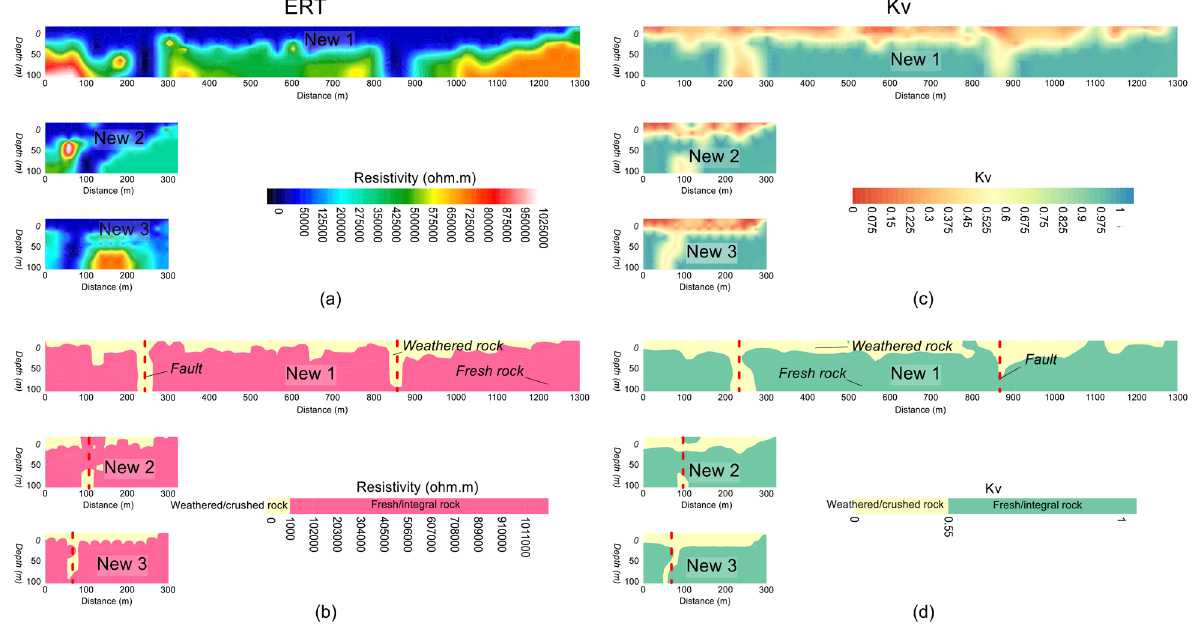
Figure 4. ( a ) 2D ERT models along three profiles New1, New2 and New3 (resistivity increasing from dark blue to red white on a color scale). ( b ) Interpretation of a for the weathered/crushed rock (yellow color) and the fresh/integral rock (red color). ( c ) 2D Kv models along profiles New1, New2 and New3 (Kv increasing from red to blue on a color scale). ( b ) Interpretation of c for the weathered/crushed rock (yellow color) and the fresh/ integral rock (green